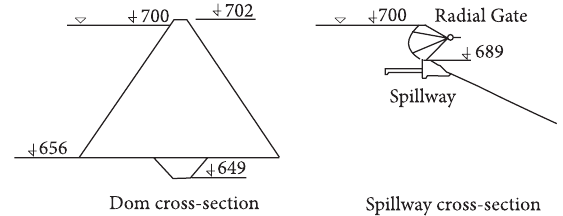
Fig. 2. Goksu dam and gated spillway structure